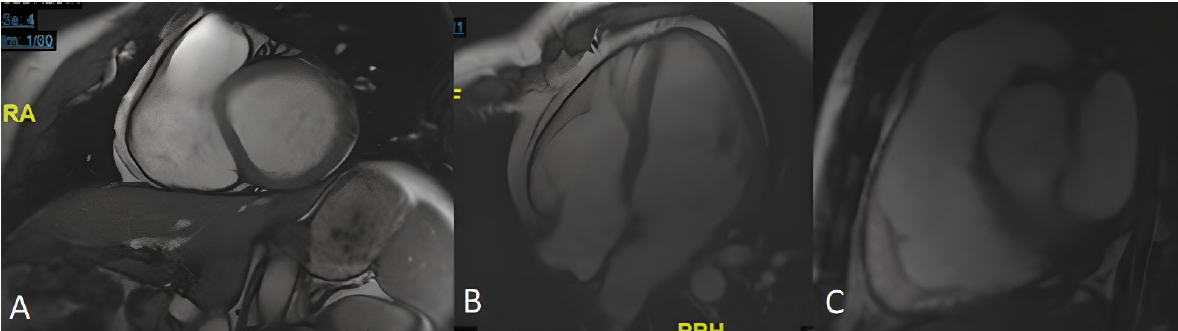
Figure 4. Cardiac CMR of index patient IV.17. The detailed study of the RV shows a non-dilated cavity, with no apparent abnormalities of the parietal contour and no evidence of fatty infiltration. The global dynamics of the right ventricle are preserved, with no alterations in segmental motility. There is no late enhancement in myocardial suppression sequences suggesting necrosis/fibrosis. ( A ) short axis; ( B ) four chambers; ( C ) right ventricle.